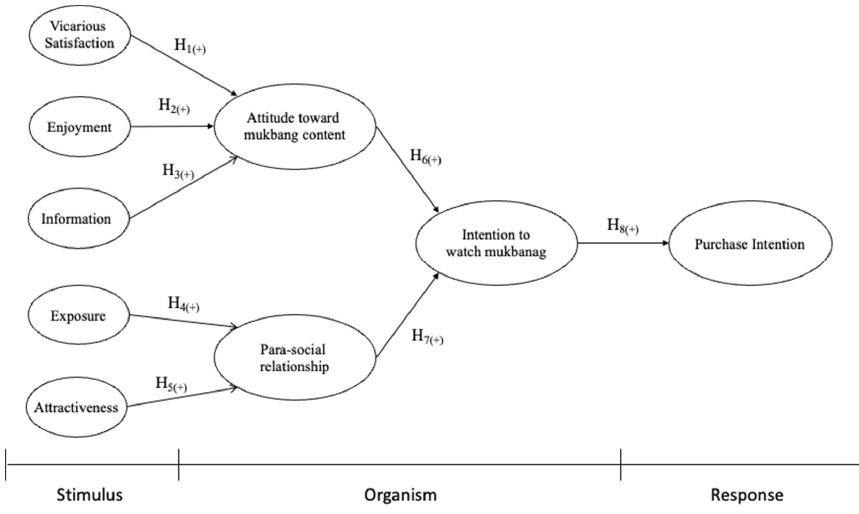
Figure 1. Research